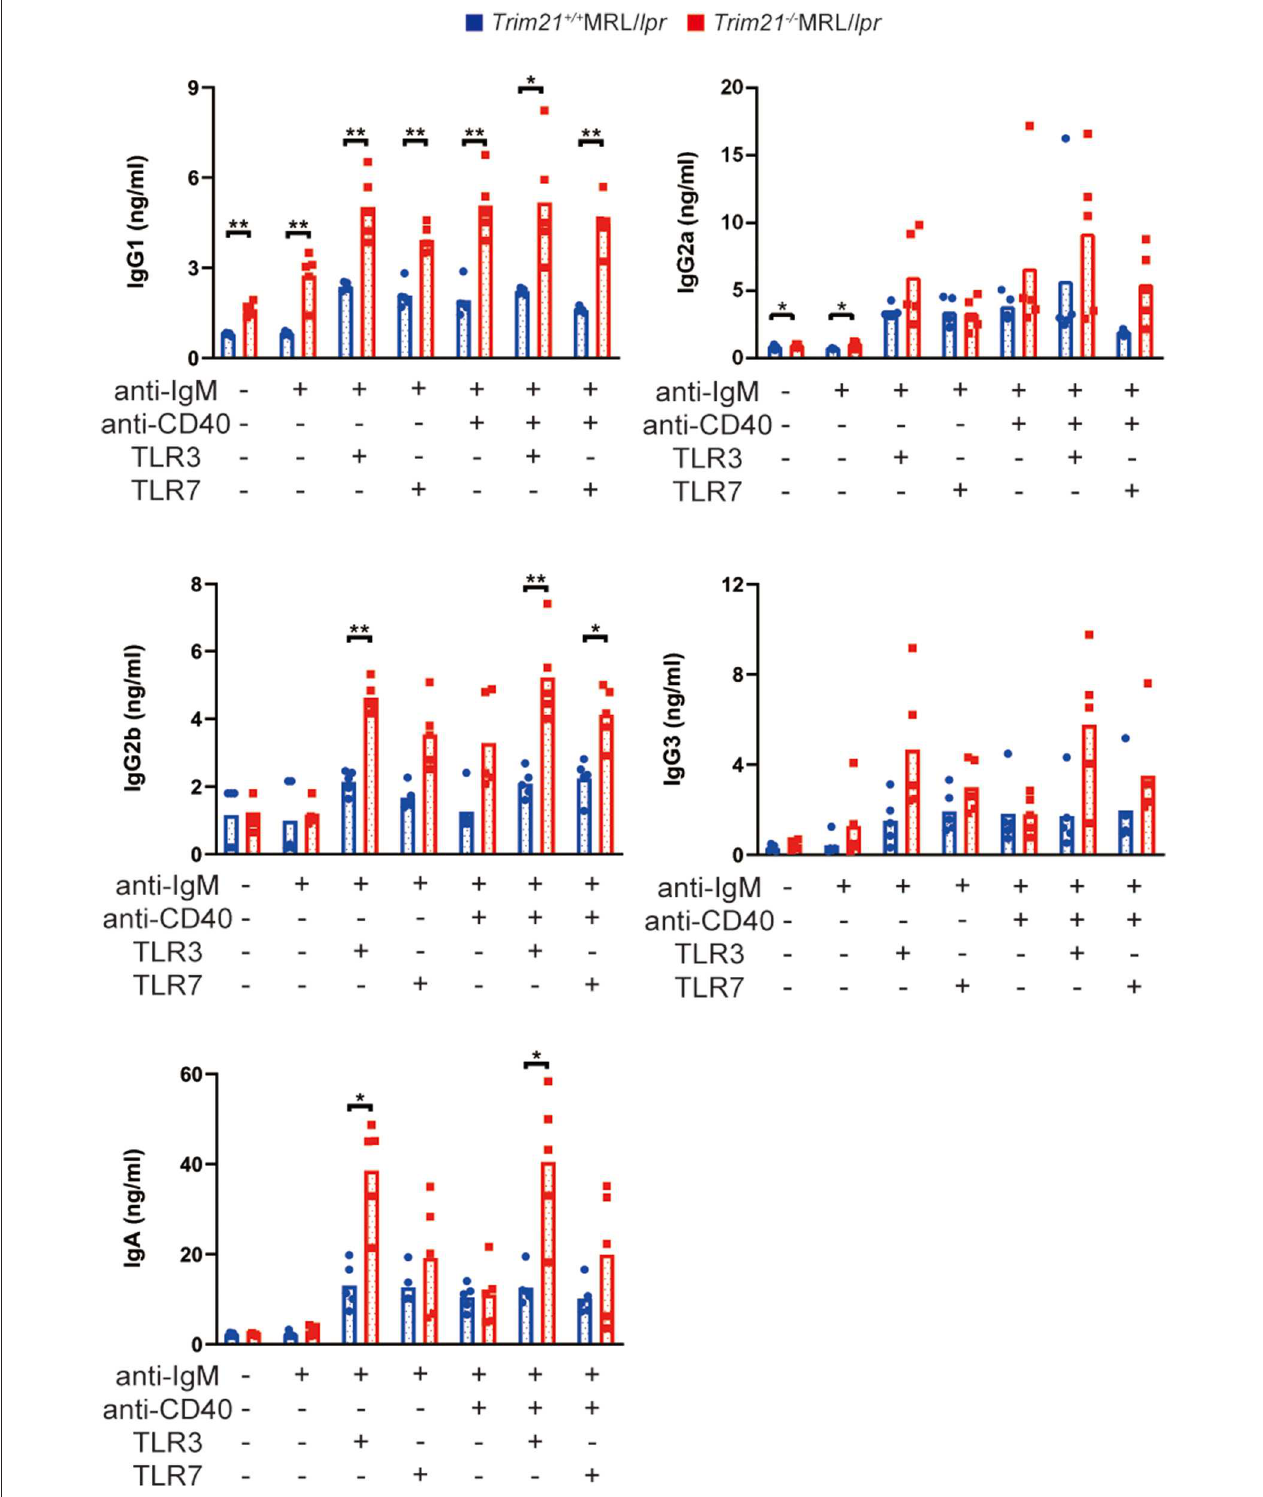
FIGURE 7 | TRIM21 deficiency promotes aberrant Ab production in MRL/ lpr mice. Concentrations of IgG1, IgG2a, IgG2b, IgG3, IgA, and IgM in culture supernatants of resting B cell stimulated with anti-IgM Ab, anti-CD40 Ab, and/or TLR3/7 ligands for 72h were measured by multiple soluble analyte immunoassays ( n = 4 in each group). Statistically significant data (* p < 0.05 and ** p < 0.01) by Student’s t -test, respectively. See also Supplemental Figure 2 .